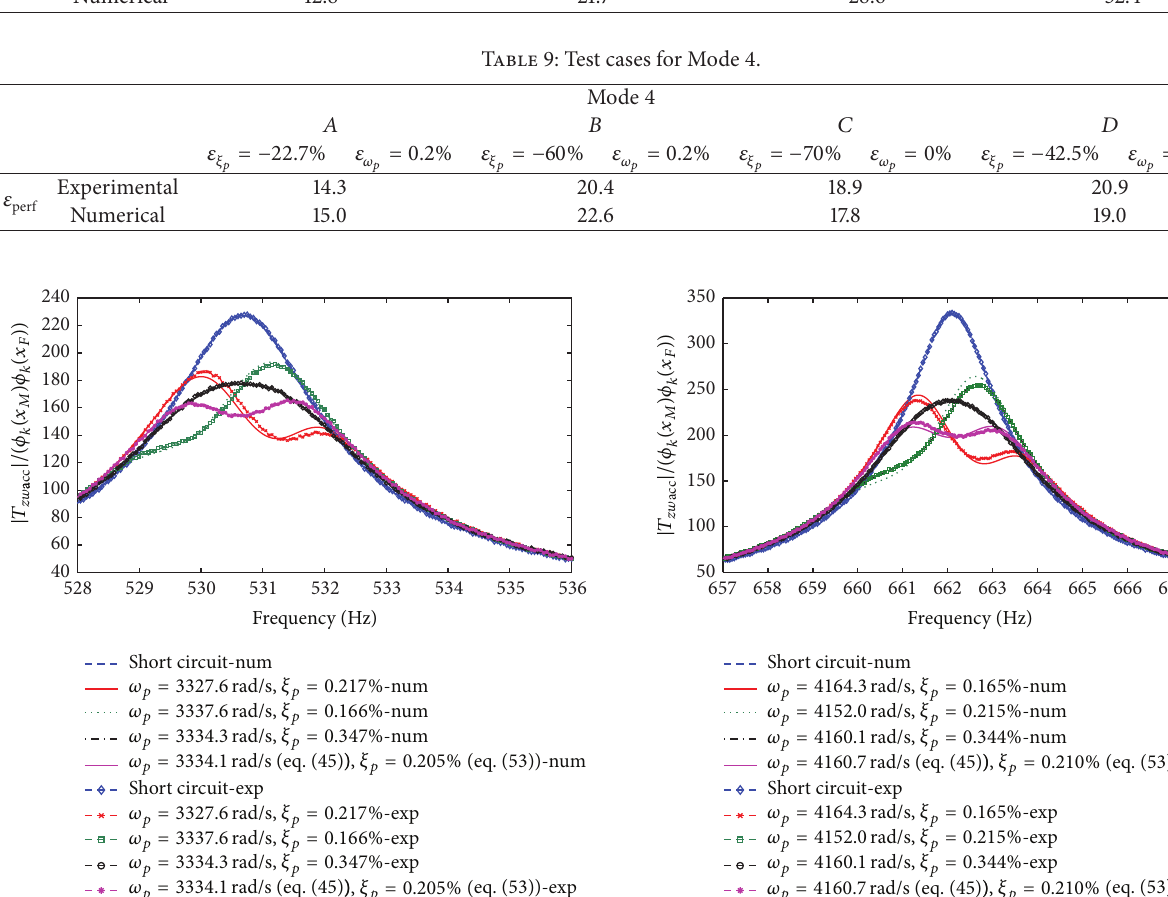
Figure 27: Numerical and experimental trend of |𝑇 𝑧𝑤 malised over Φ 𝑘 (𝑥 𝑀 )Φ 𝑘 (𝑥 𝐹 ) ) for the mode at about 530 Hz (Table 7) and fixed values of 𝜔 𝑝 and 𝜉 𝑝 .